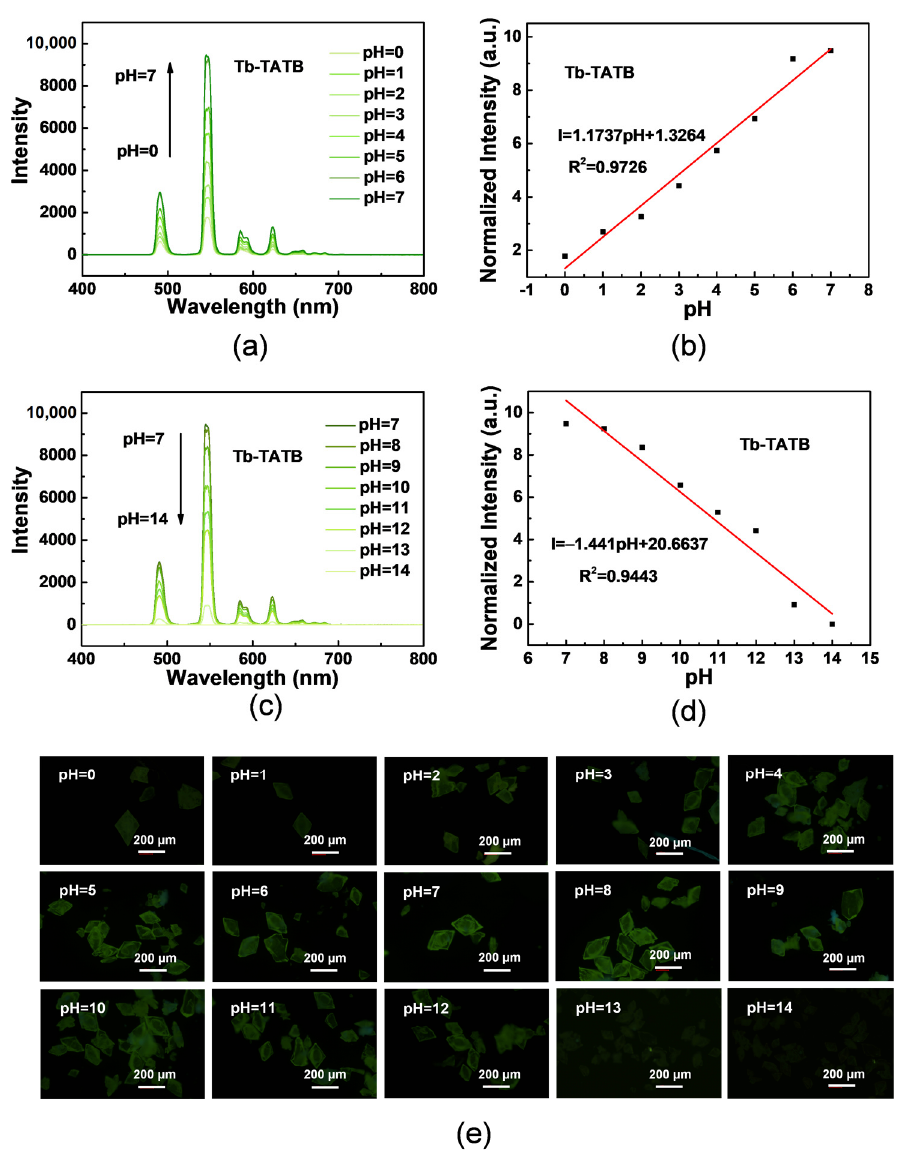
Figure 6. ( a , c ) The change in fluorescence emission intensity of Tb-TATB treated by HCl/NaOH aqueous solutions with pH ranging from 0 to 14. ( b , d ) The linear variation of the emission (545 nm) intensity for Tb-TATB treated by HCl/NaOH aqueous solutions with pH ranging from 0 to 14. ( e ) Fluorescence microscope images of Tb-TATB at different pH (pH =